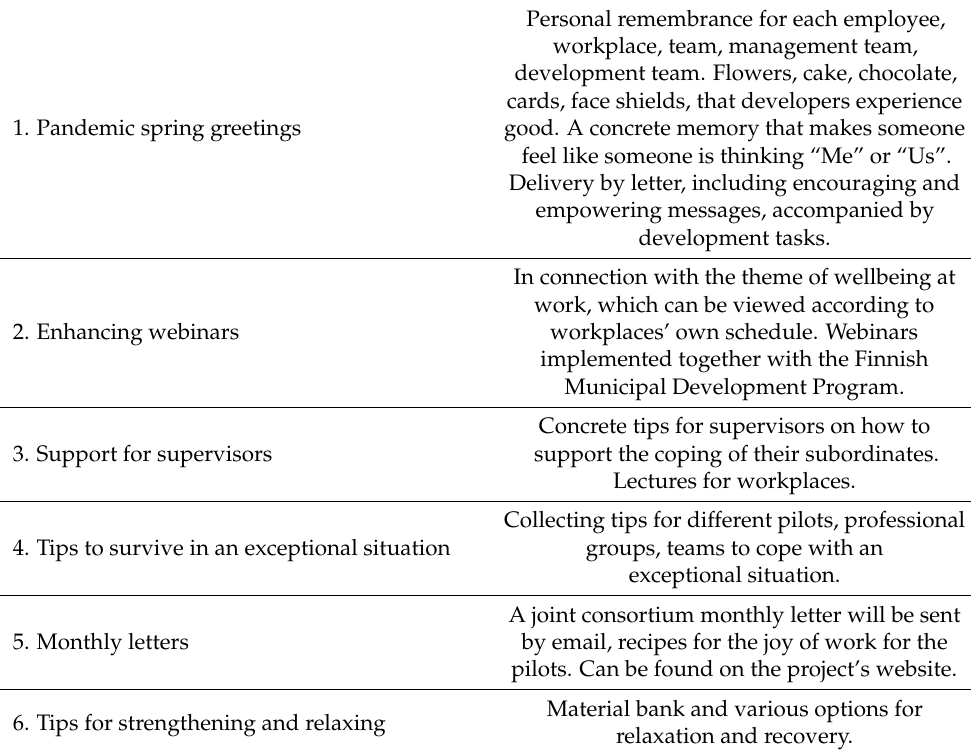
Table 3. The results of creative brainstorming at the beginning of the transition